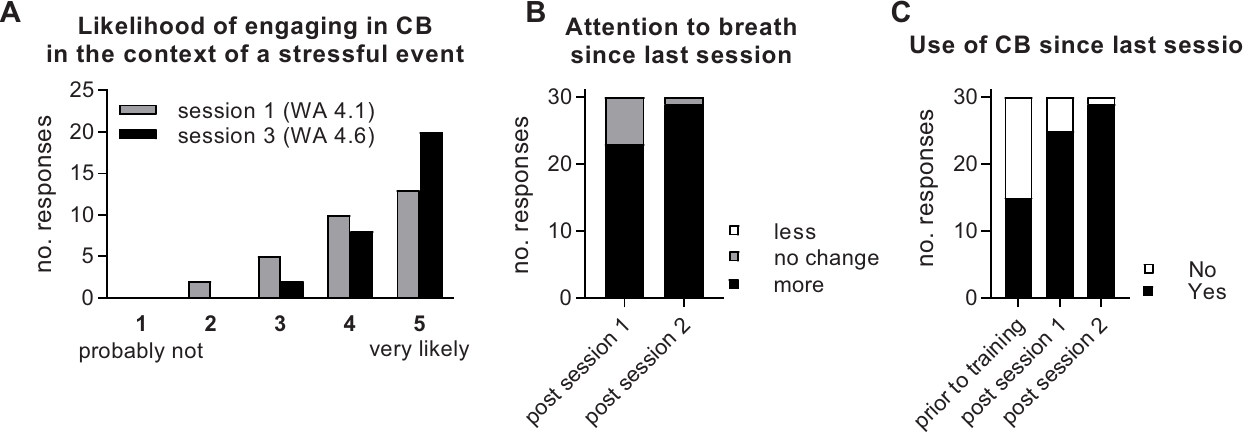
Fig 4. User-reported effects of Performance Edge VR training on controlled breathing behaviours. Users self-reported A) likelihood of engaging in controlled breathing in response to a stressful event in the future and B) their level of attention to their breathing in the week between sessions. C) Participant- reported use of controlled breathing before initiating training and between training sessions. Data presented on a 5-point Likert scale (WA = weighted averages) and individual responses (n = 30).